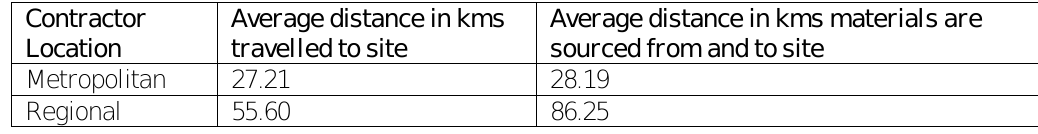
Table 7: Distances